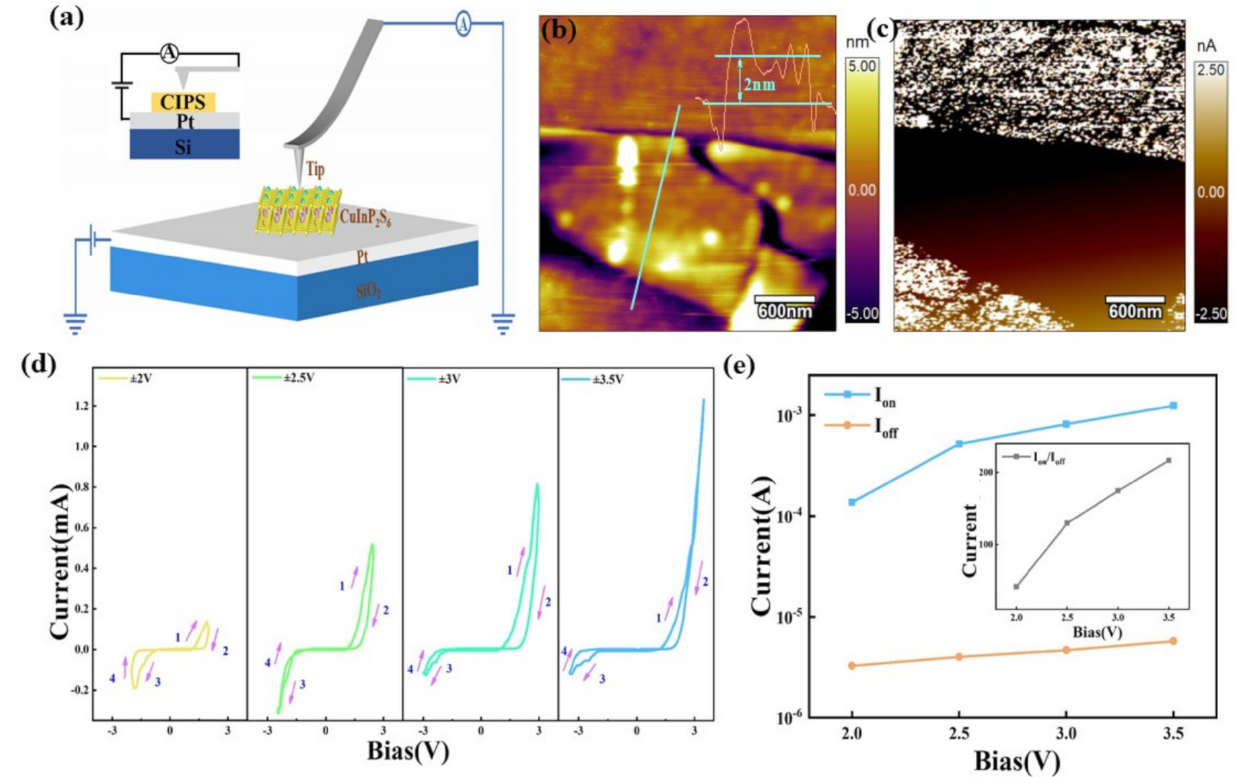
Figure 5. Electrical characterization of a Si/Pt/CIPS/Au diode with1.7 nm CIPS. ( a ) Schematic representation of the experimental setup for C-AFM measurements. ( b ) Topography image of the CIPS nano flake with a thickness of 2 nm on the Si/SiO 2 /Ti/Pt substrate. The inset shows the height map of the CIPS flake. ( c ) The corresponding current phase diagram of CIPS flakes. ( d ) I – V curves measured with increasing sweep voltages, where V Max is from 2 to 3.5 V. ( e ) I on and I off are the on and off current of the FTJ with resistance switching behavior, which are also corresponding to the low and high resistance states, read from ( d ) under different scanning voltages, with the inset the calculated switching ratio based on ( d